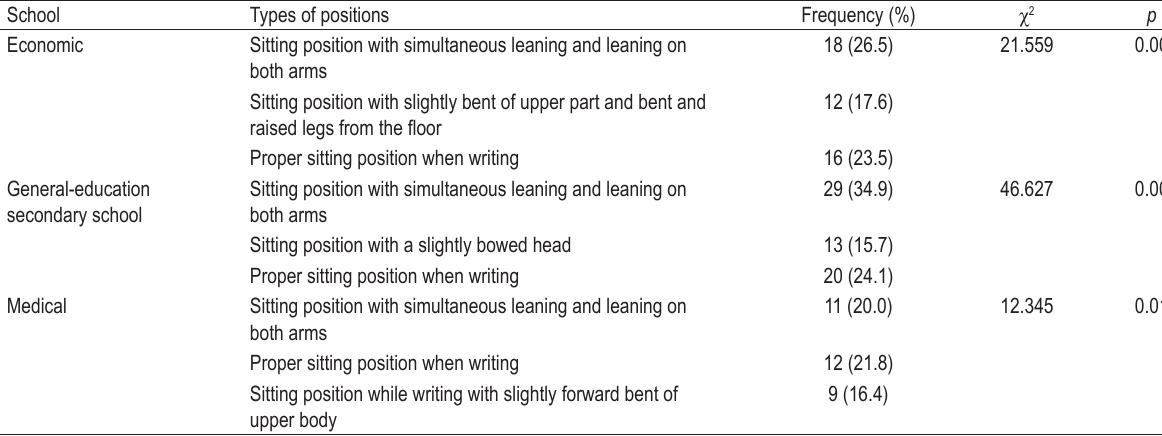
TABLE 4. The most common positions that students take when writing